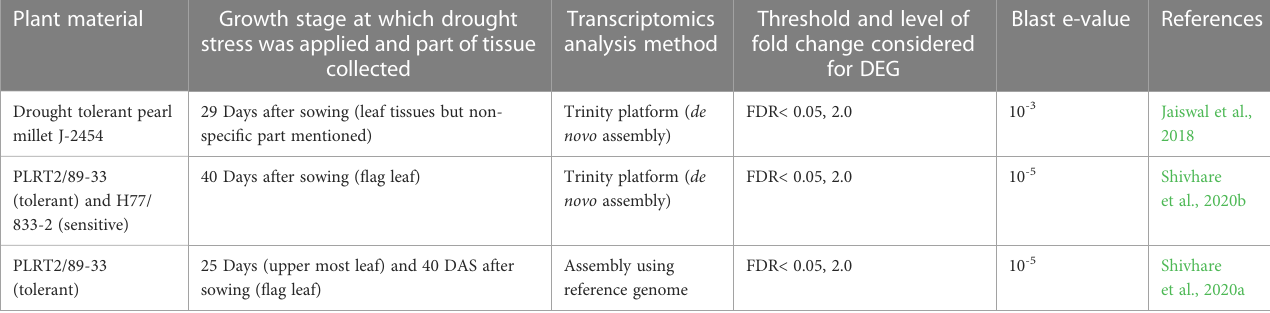
TABLE 2 Summary of published transcriptomics data used in our study with detailed information on methodology and data sets. Plant